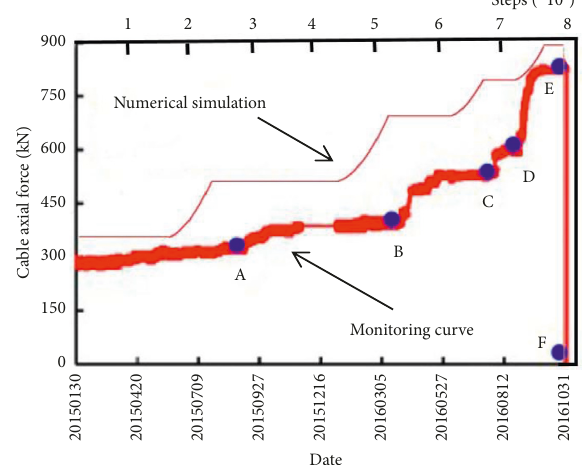
Figure 30: Comparison of numerical simulation curve and monitoring